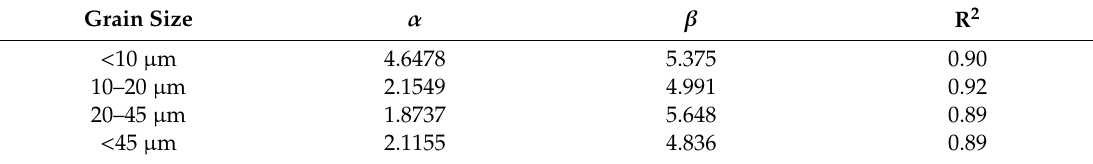
Figure 3. Correlation of SSA at 540 nm and npFe 0 for each grain size group of LSCC samples. Solid color lines represent regression lines for different size groups of lunar samples Table 2. Model parameters and R 2 for each grain size group of LSCC data.